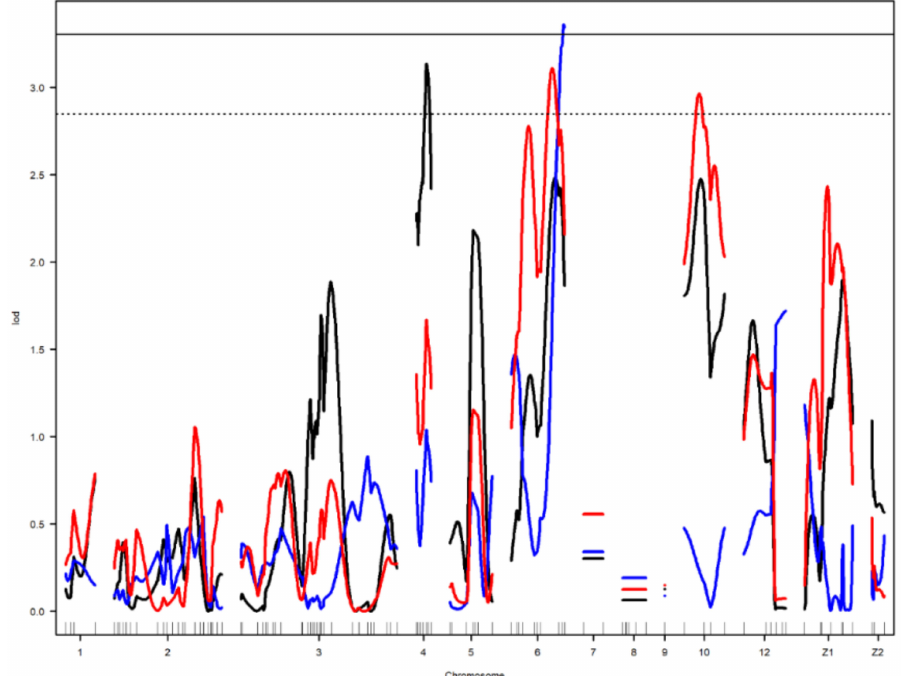
Figure 3. Genome-wide LOD plot of detected QTL for egg long axis 1 (black) on chromosome 4, yolk weight 1 (red) on chromosomes 6 and 10, and egg shell strength 1 (blue) on chromosome 6. The horizontal lines show the genome-wide significance at 5% (straight line) and suggestive threshold at 10% (dotted line)